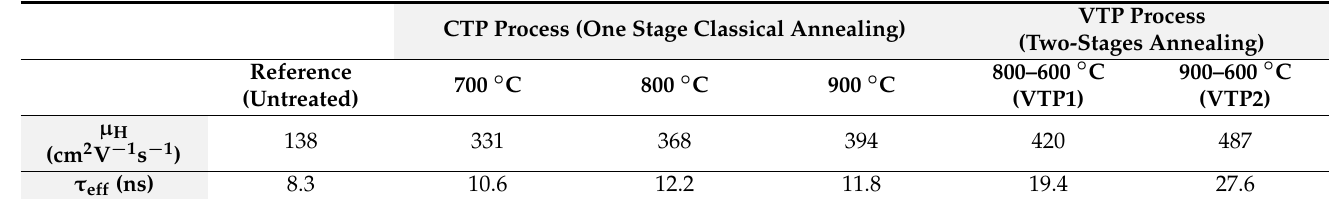
Table 1. The effective minority carrier lifetime ( τ eff ) and the majority hall mobility ( µ H ) in p-GaAs before (untreated reference) and after the gettering process as a function of temperature. CTP Process (One Stage Classical